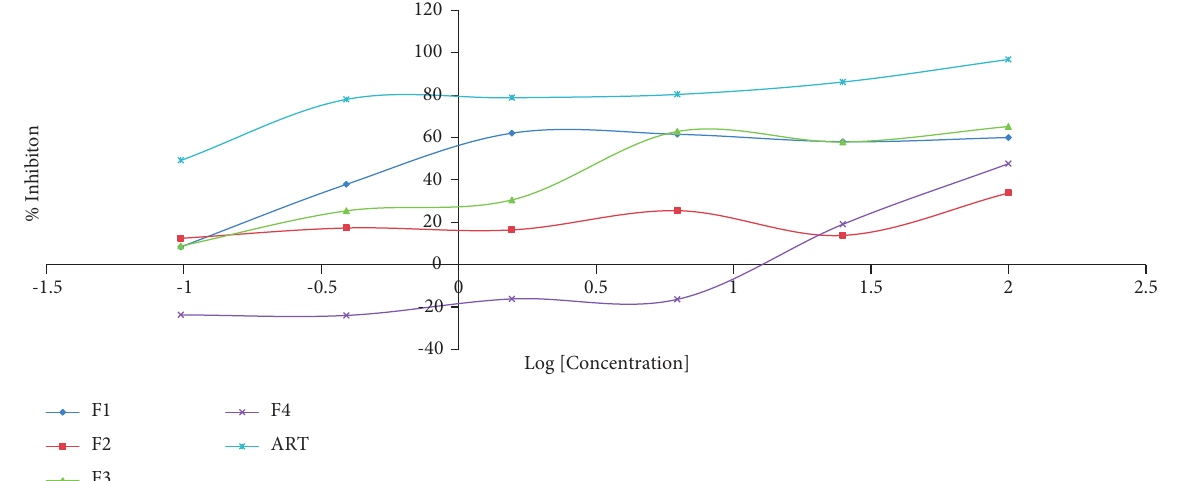
Figure 5: A plot of % inhibition of fractions versus log of